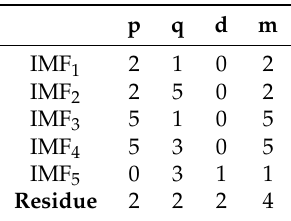
Table 1. Order of the autoregressive integrated moving average (ARIMA ( p , d , q ) ) models fitted to each intrinsic mode function (IMF) and to the residue. The number of lagged values m = p + d was used to construct the input vectors for the empirical mode decomposition–support vector regression (EMD–SVR)